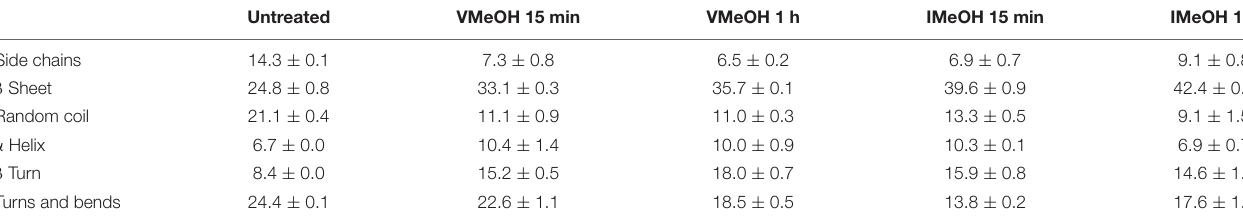
TABLE 3 | Secondary structures percentages of SFW treated with MeOH and untreated